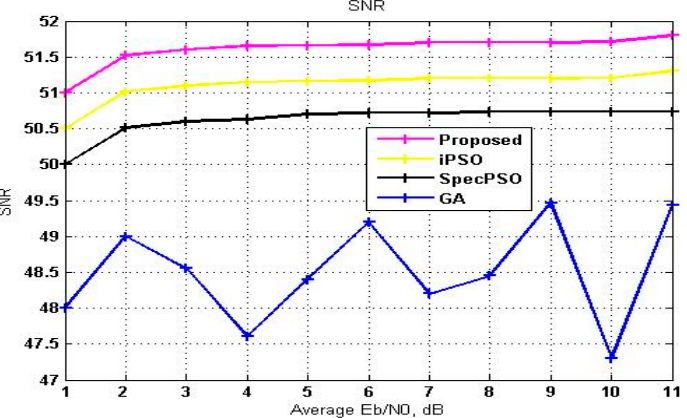
Figure 5. SNR vs. average E b /N o.